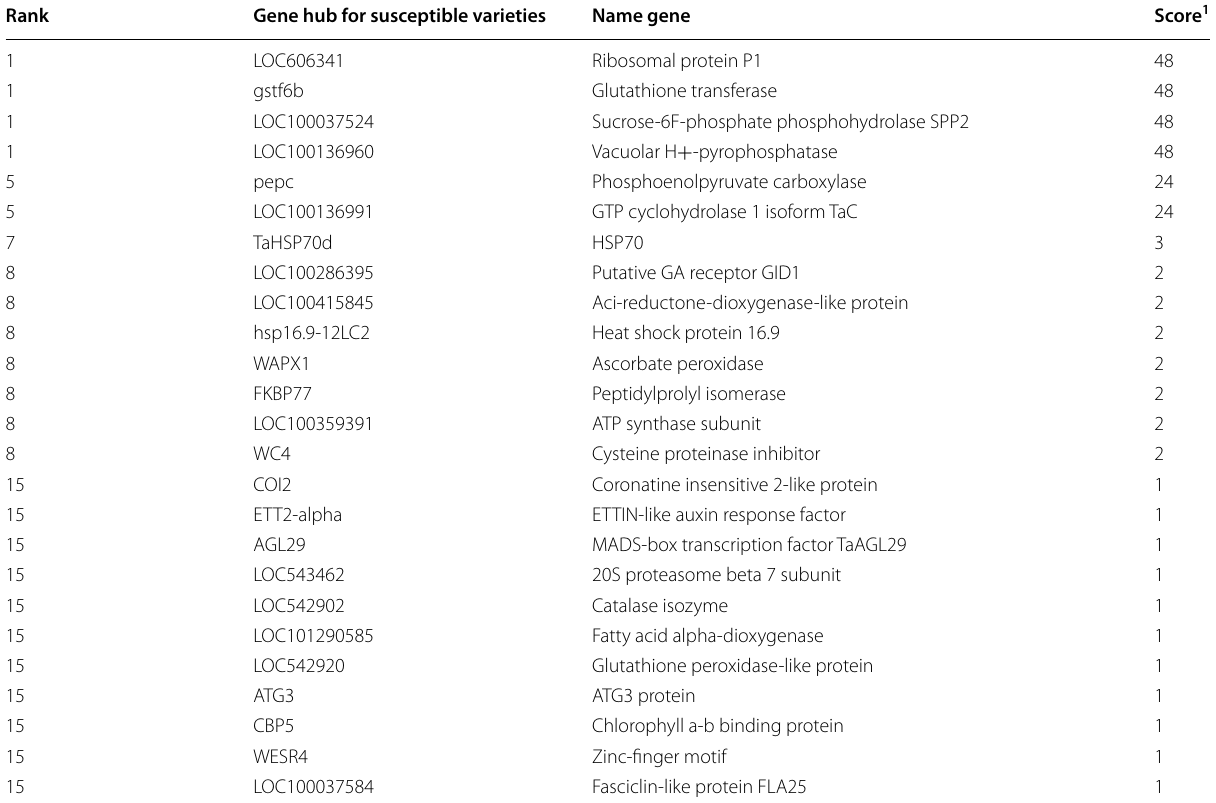
1 Scores are based on the MCC